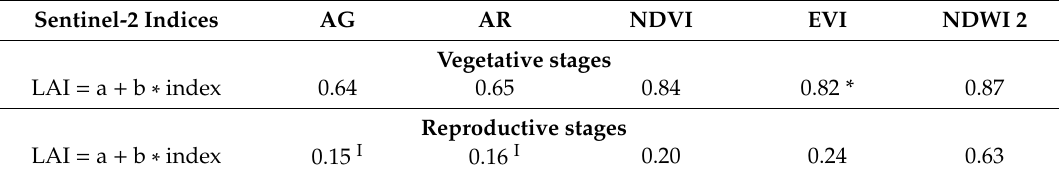
Table 5. Coe ffi cients of determination (R adj2 ) of a linear regression model for both years between LAI and Sentinel-2 spectral indices (LAI = a + b ∗ Index) for the vegetative ( n = 22) and the reproductive stages ( n = 18) in a rainfed barley ( Hordeum vulgare L.) in Madrid, Spain. Sentinel-2 Indices AG AR NDVI EVI NDWI 2 Vegetative stages LAI = a + b ∗ index 0.64 0.65 0.84 0.82 *